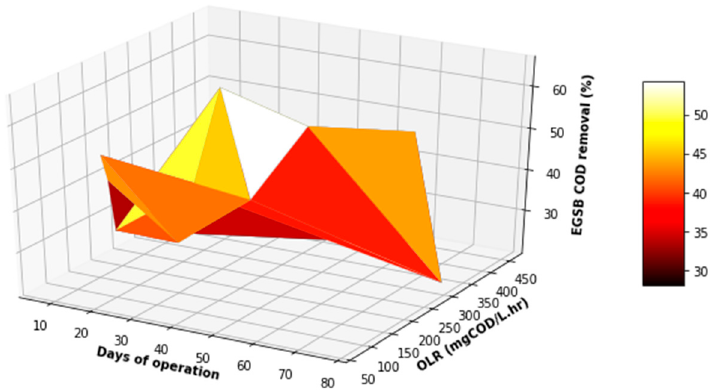
Figure 12. Variation in COD removal with differentiated OLR during the EGSB operational time.